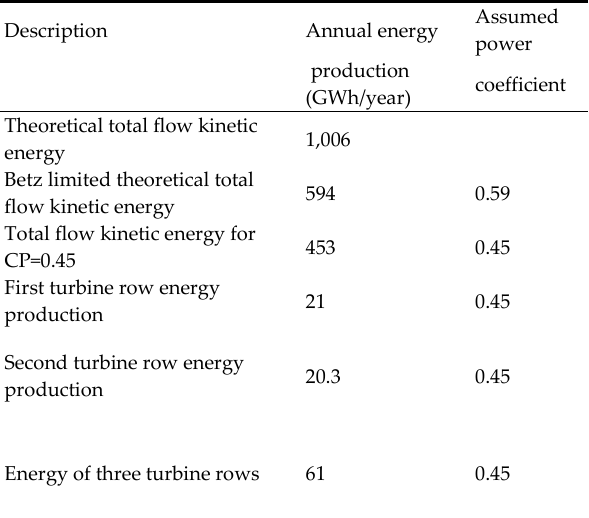
where 𝑌 represents the period (1 year in this case). The 𝐸 = 0.59𝐸 𝑎, 𝐵𝑒𝑡𝑧 𝑎0 . While, considering a power coefficient of 𝐶 𝑃 = 0.45 , the amount of annual available energy in the current flow is equal to 𝐸 = 0.45 𝐸 𝑎, 𝐶 𝑃 =0.45 𝑎0 .